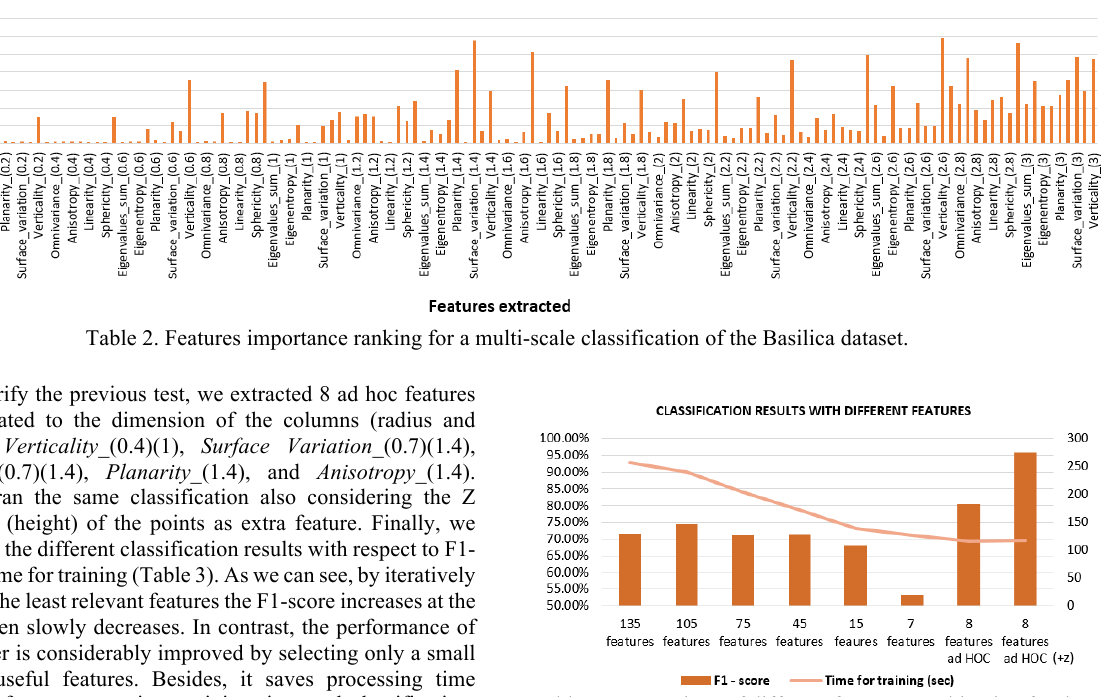
Table 3. Comparison of different features combination for the Basilica’s classification, wrt F1-score and time of training.